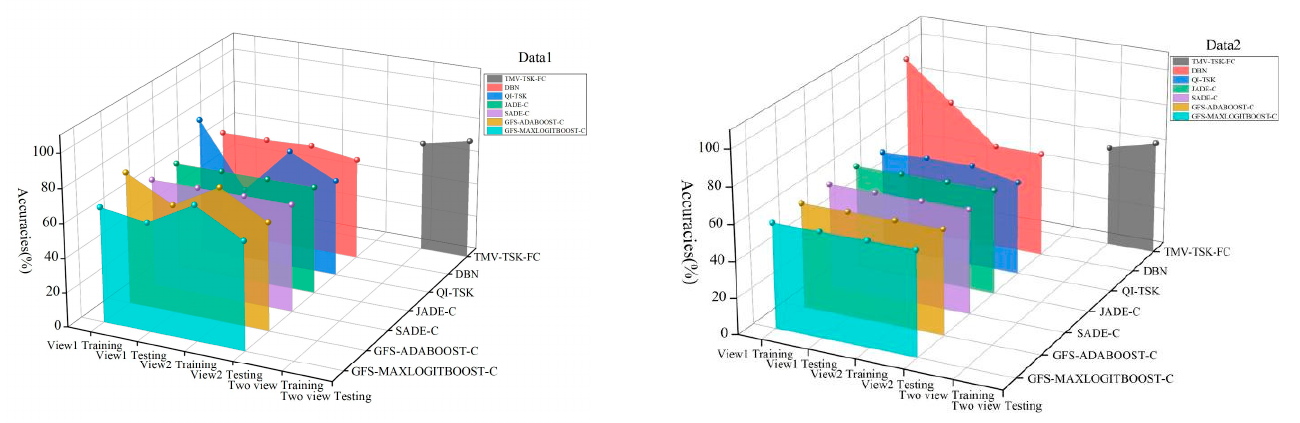
Figure 7. Comparison between TMV-TSK-FC and the other algorithms.